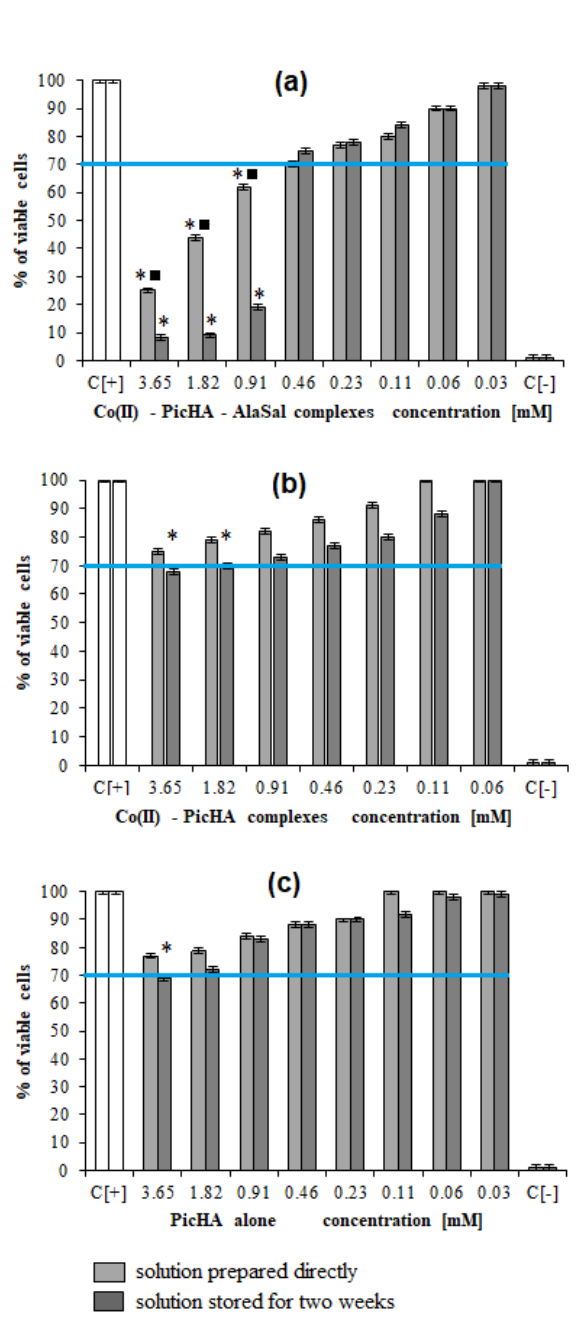
Figure 5. Cytotoxic effect of the studied complex and ligand forms: ( a ) Co(II)–PicHA–AlaSal, ( b ) Co(II)–PicHA and ( c ) PicHA towards mouse fibroblasts L929. The cytotoxicity was assessed by 3-(4,5-dimethylthiazol-2-yl)-2,5-diphenyltetrazolium bromide (MTT) reduction assay. The cell viability was calculated for four experiments including three repeats for each compound. Complete RMPI-1640 medium (cRPMI) was used as a positive control (C+) of cell viability (100% viable cells) and 0.03% H 2 O 2 as a negative control (C − ) of cell viability (100% dead inactive cells). Statistical significance: * ■ p < 0.05; * untreated cells vs. cells treated with tested solution (solution prepared directly or solution stored for two weeks); ■ solution prepared directly vs. solution stored. The blue line indicates the minimal percentage of viable cells (70%) required to confirm the compound as noncytotoxic at the in vitro level. Data are presented as mean values ± SD.